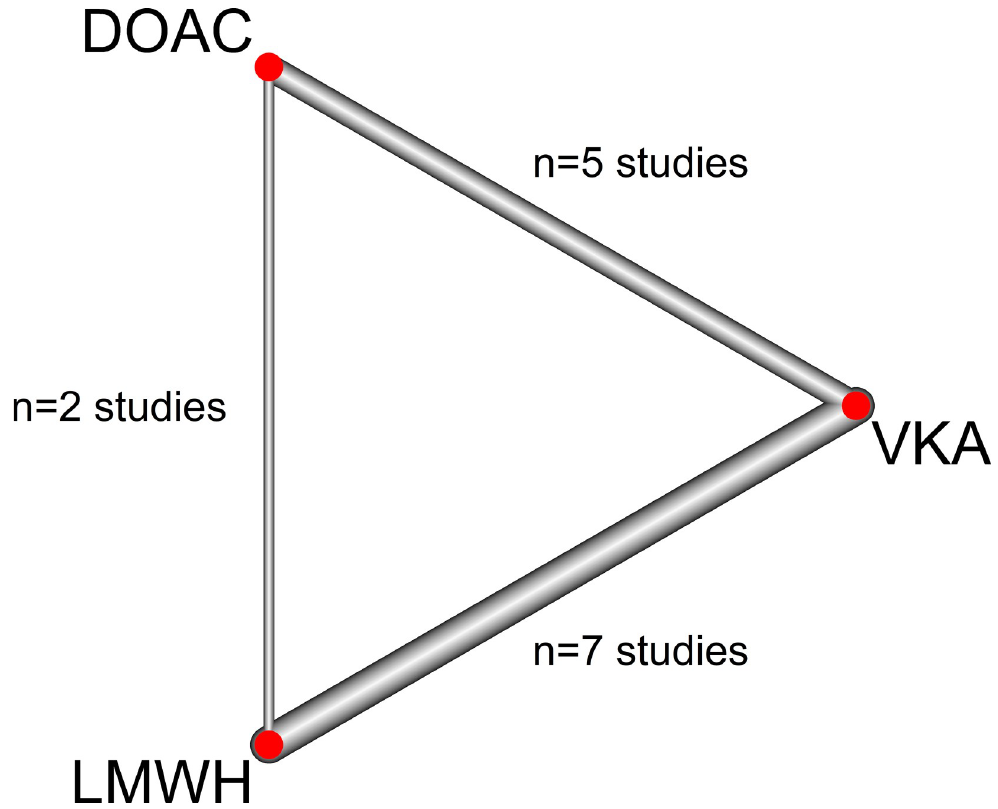
Fig 2. Diagram of the